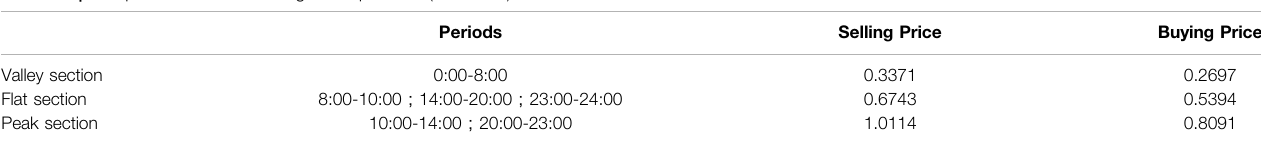
TABLE 2 | ToU price of the ADN after game equilibrium (CNY/kWh). Periods Selling Price Buying Price Valley